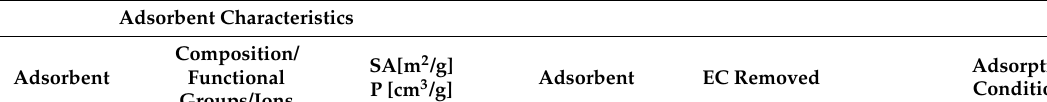
Table 2. Conventional materials used for ECs removal from synthetic water in batch